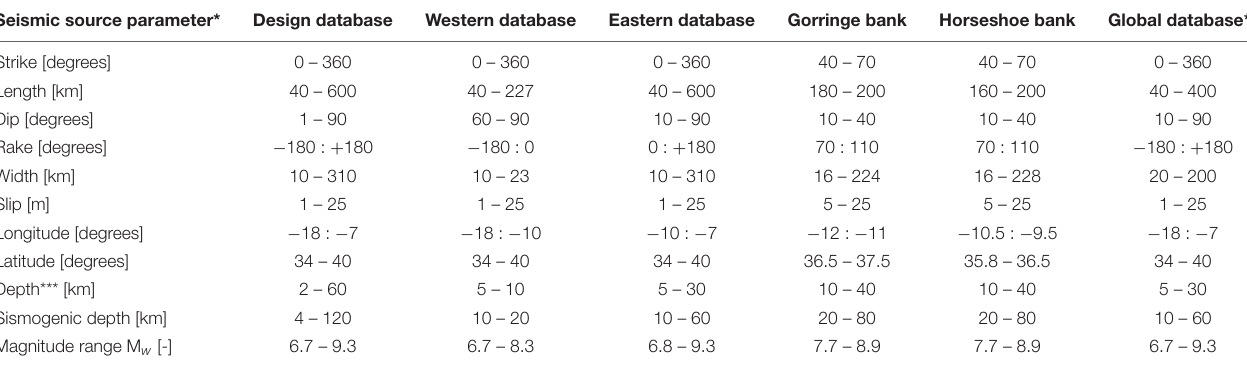
TABLE 2 | Summary of the variation range of the seismic source input parameters for the design, the western, the eastern database and for the tsunami scenarios associated to the Gorringe bank and the Horseshoe bank (hypothesis from Duarte et al., 2013; Grevemeyer et al., 2017). Seismic source parameter*